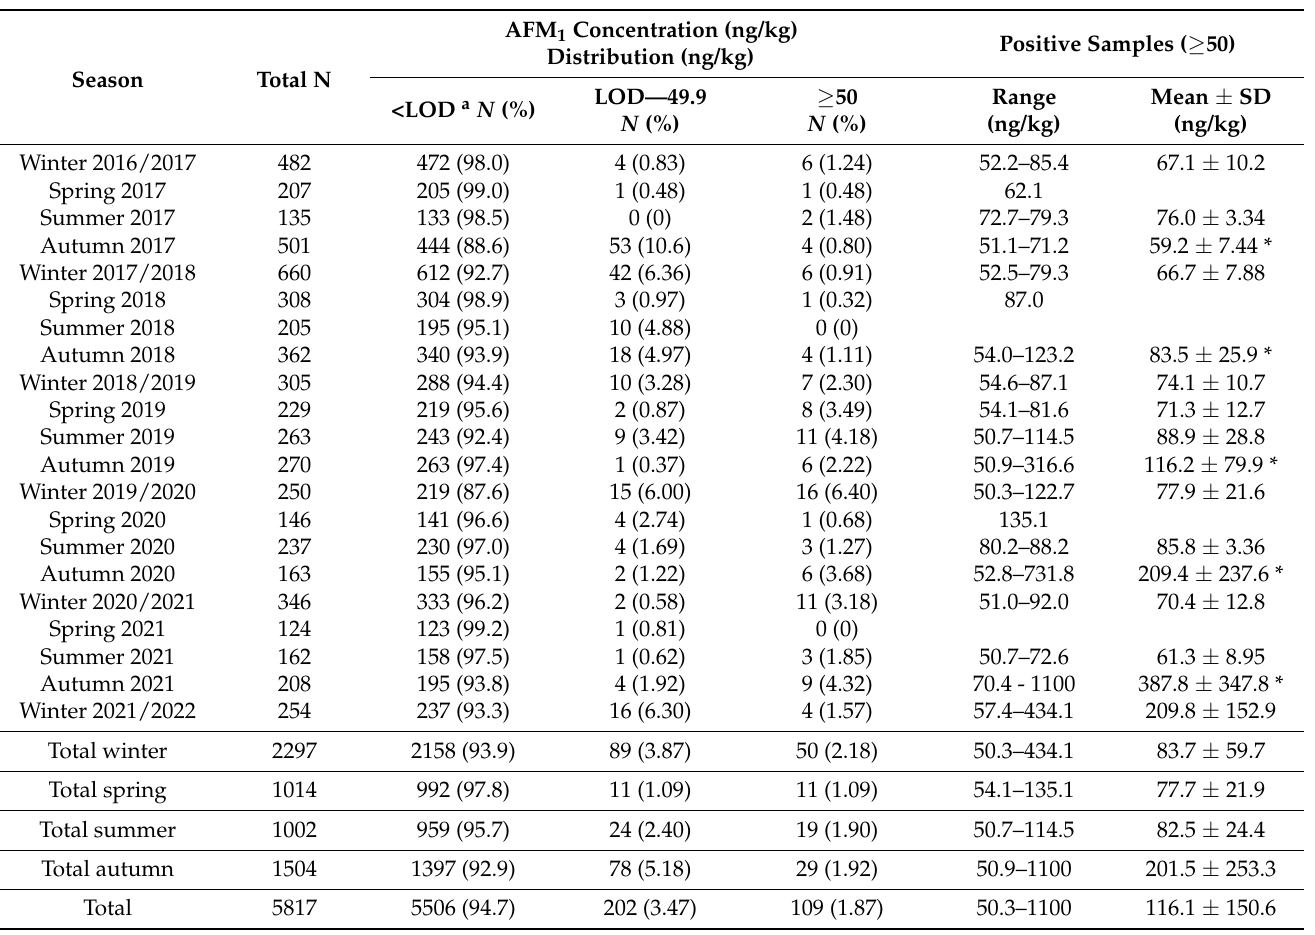
Table 2. Occurrence and distribution of AFM 1 in raw cow samples collected in Croatia during five years period between winter 2016/2017 and winter